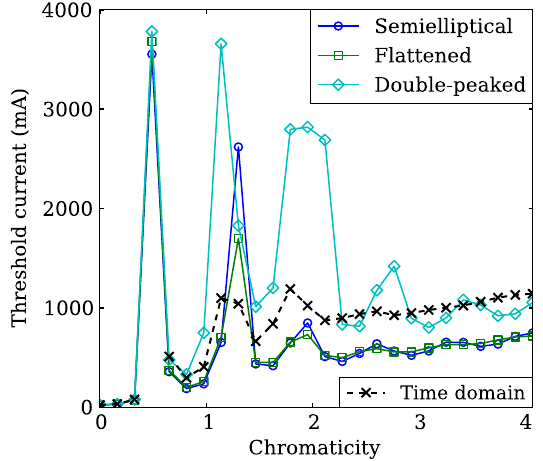
FIG. 20. Threshold current for the coupled-bunch resistive-wall instability in the 3 GeV ring with a BBR included for the case with a harmonic cavity flat potential. Results of macroparticle simulations in the time domain are compared with those obtained using a frequency domain computation of the m ¼ 0 head-tail mode for three non-Gaussian distributions.